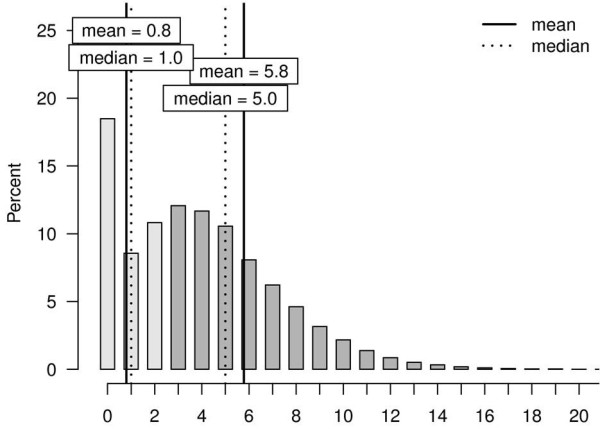
Frequency (in %) of the number of chronic conditions within the list of 46 conditions in the non-multimorbid sample (light grey columns) and the multimorbid sample (dark grey columns) and mean and median for both samples.